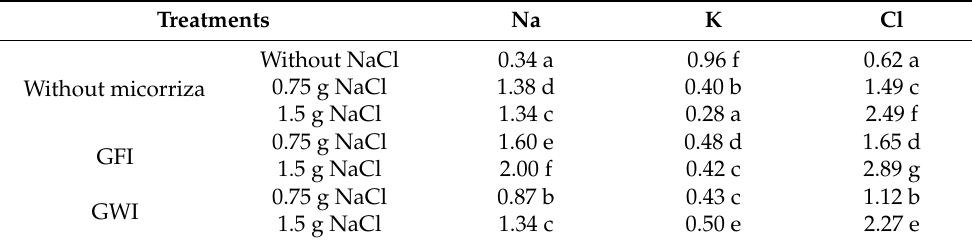
Equal letters in the same column indicate statistically equal means from Duncan’s Test at 95%